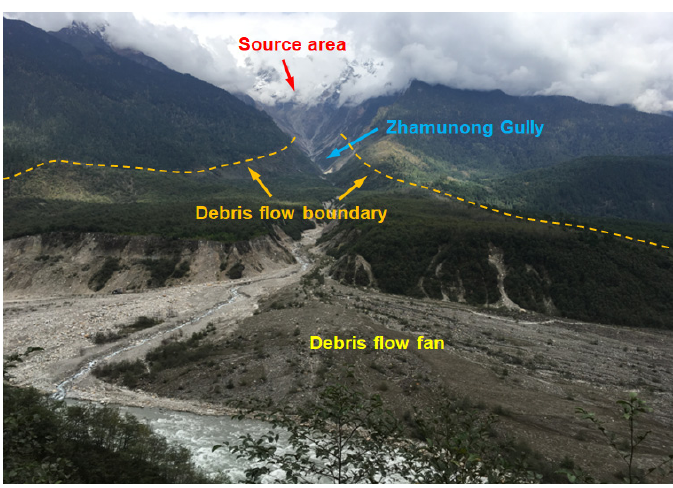
Figure 6. Front view of the deposit zone (view direction NE, photo by Dai in October 2016).